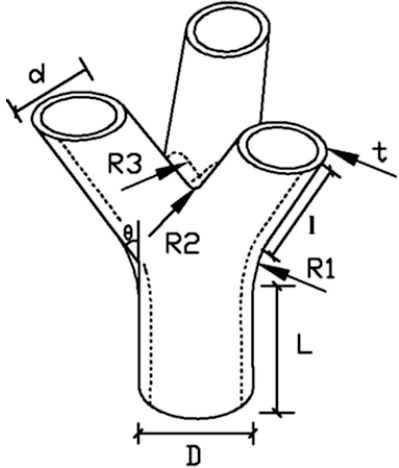
Figure 12. Geometrical features of joint. Table 5. Actual print size of the test piece